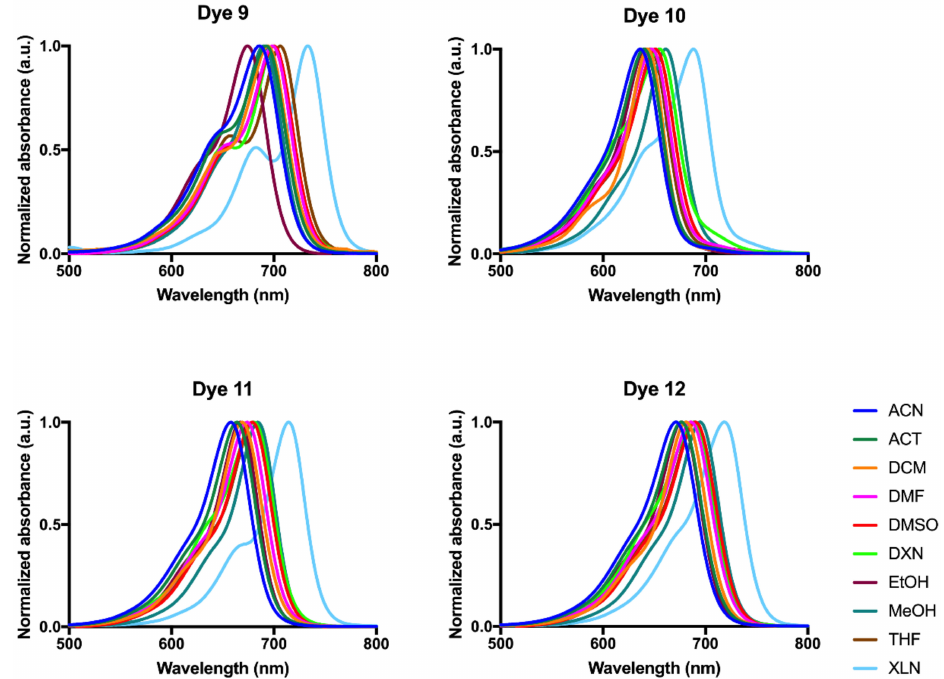
Figure 1. Normalized red and near-infrared absorption spectra of quinoline- and benzoselenazole- derived unsymmetrical squaraine cyanine dyes 9 – 12 acquired in acetonitrile (ACN), acetone (ACT), dichloromethane (DCM), dimethylformamide (DMF), dimethyl sulfoxide (DMSO), 1,4-dioxane (DXN), ethanol (EtOH), methanol (MeOH), tetrahydrofuran (THF) and xylene (XLN) at room temperature. Absorption is presented as arbitrary units (a.u.). Table 2. Red and near-infrared spectroscopy data of quinoline- and benzoselanazole-derived unsymmetrical squaraine cyanine dyes 9 – 12 in organic solvents [acetonitrile (ACN), acetone (ACT), dichloromethane (DCM), dimethylformamide (DMF), dimethyl sulfoxide (DMSO), 1,4-dioxane (DXN), ethanol (EtOH), methanol (MeOH), tetrahydrofuran (THF), xylene (XLN)] and aqueous